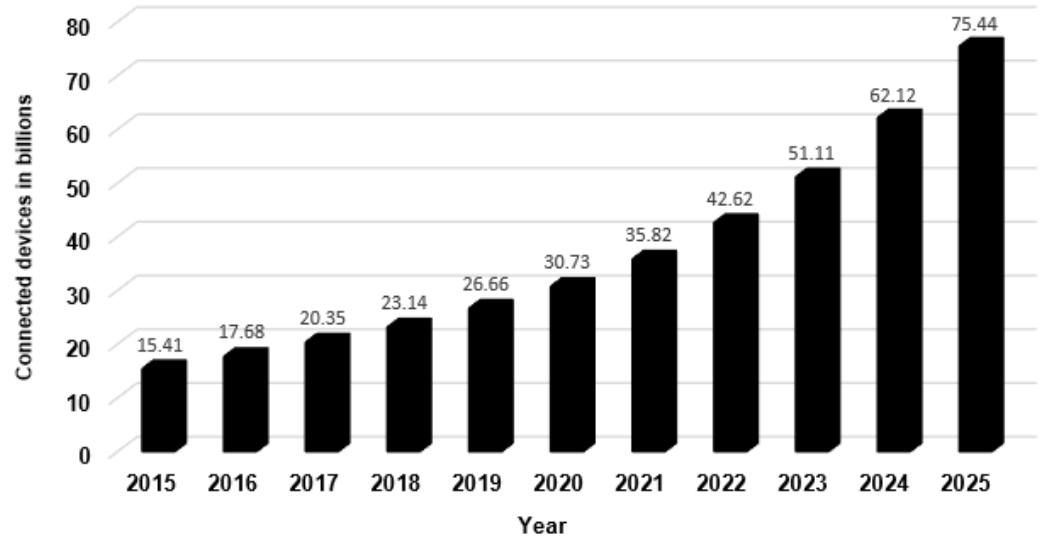
Figure 1. Expected Internet of Things (IoT) growth from 2015 to 2025 [3].